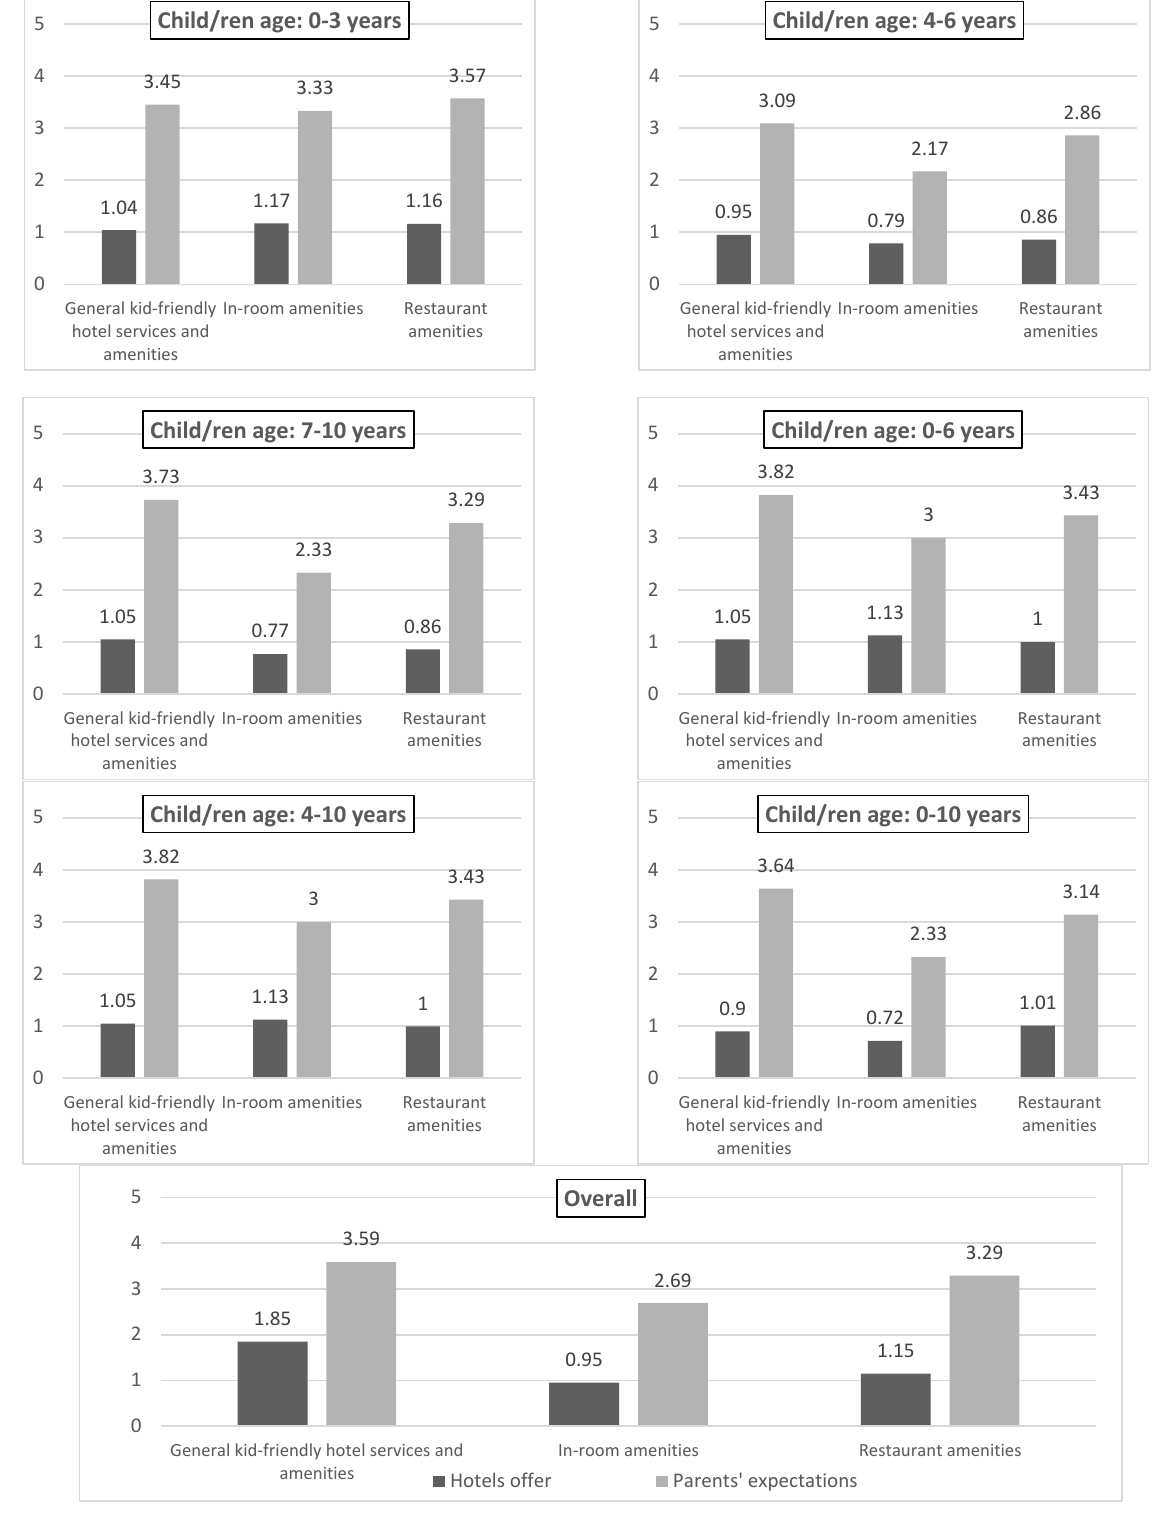
Figure 1. Amenities for families with children in relation to expectations.